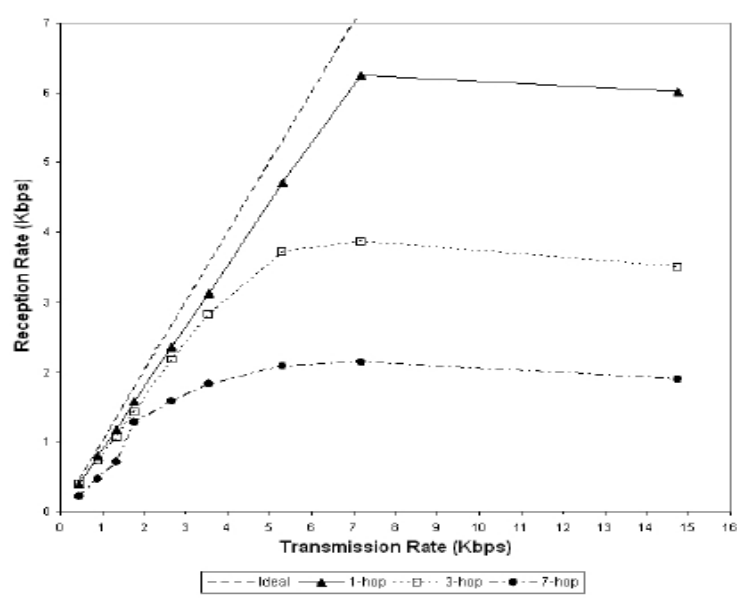
Figure 6. The performance of reception